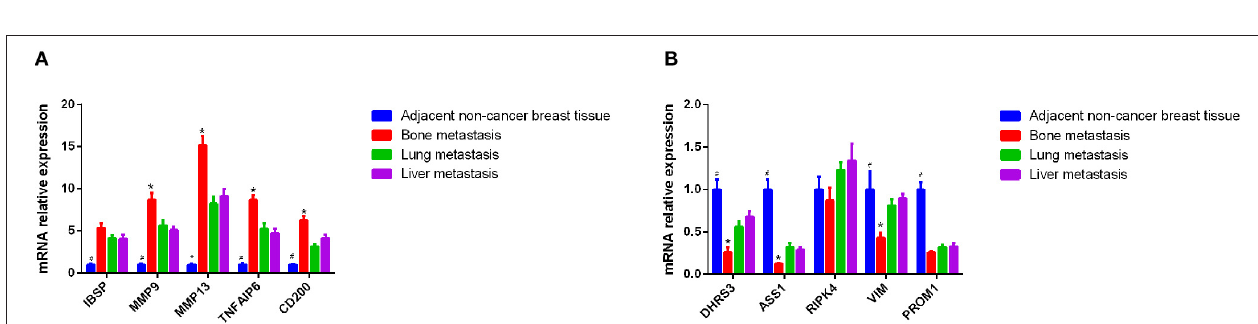
FIGURE 4 | The TFs-target genes networks. In the network, the hexagon and rectangle presented the TFs and DEGs, respectively. The rose red and green ellipse presented the up- and down-regulation, respectively.